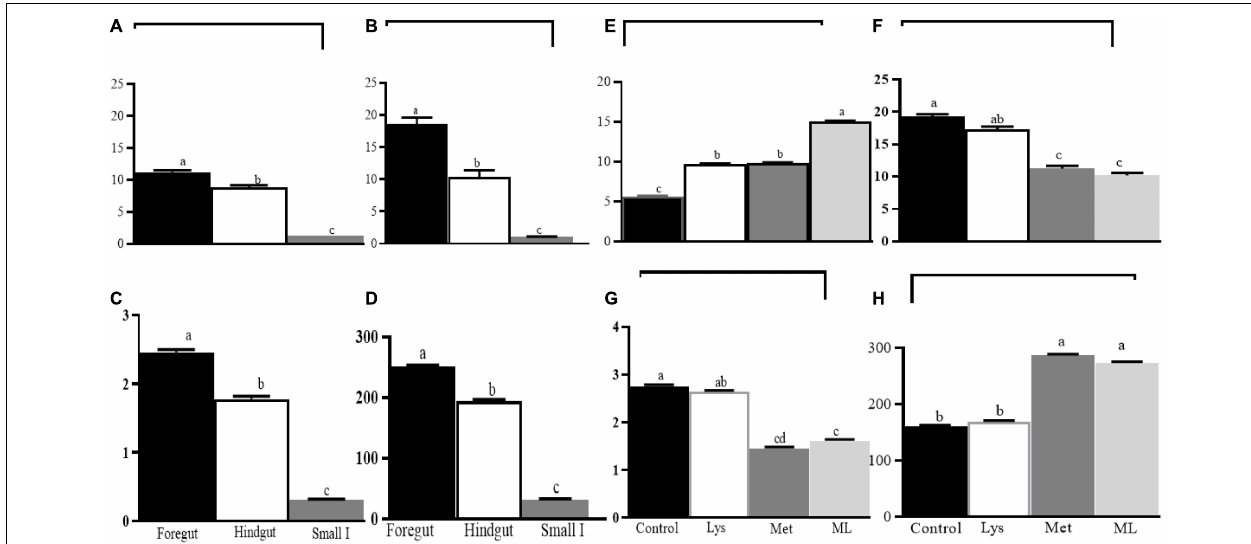
FIGURE 2 | Least square and standard error of means (SEM) for the effect of gut and dietary amino acids, respectively, on microbial fermentation metabolome (A) ammonia production (mM), (B) dissolved hydrogen (dH 2 ; µ M), (C) dissolved methane (dCH 4 ; mM), (D) dissolved hydrogen sulfur (dH 2 S; mM), and (E) ammonia production (mM), (F) dissolved hydrogen (dH 2 ; µ M), (G) dissolved methane (dCH 4 ; mM), (H) dissolved hydrogen sulfur (dH 2 S; mM). Different letters on the top of bars for the gut reigns and, amino acid supplement, respectively, indicate significantly different at p <